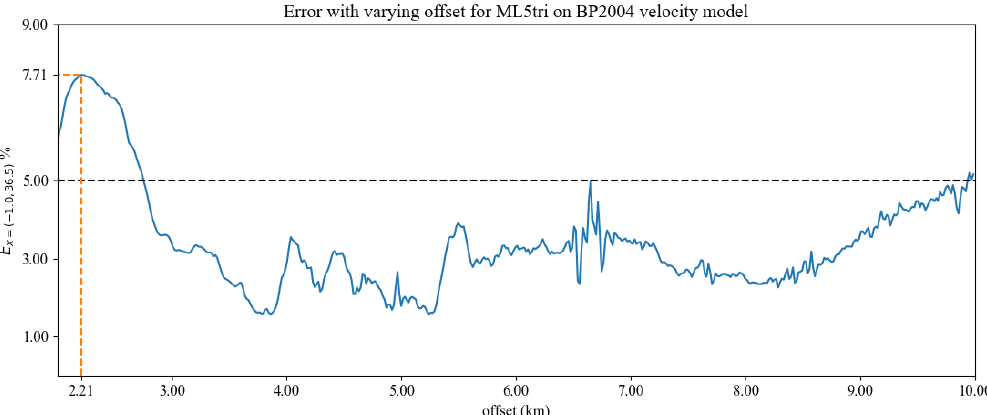
Figure 10. E (Eq. 40) as a function of the offset distance for ML5tri in the heterogeneous model setup. Peak E is annotated with dashed orange